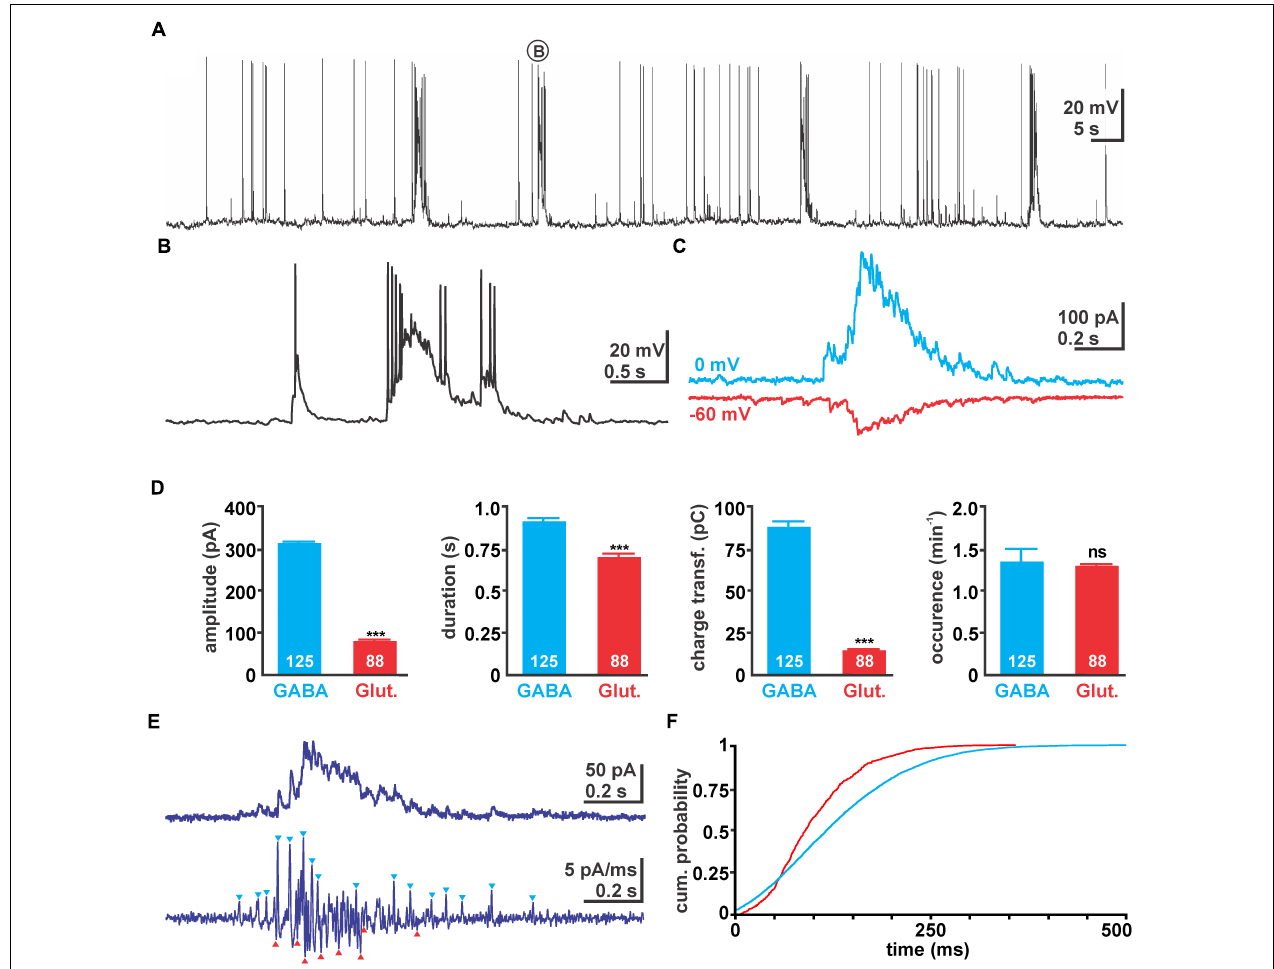
FIGURE 1 | Properties of giant depolarizing potential (GDP) activity in immature hippocampal slices. (A) Typical voltage traces recorded with 50 mM [Cl − ] p . Note the occurrence of massive depolarizing shifts triggering several action potentials (APs). (B) One typical GDP as indicated in (A) in higher temporal resolution. (C) Typical GDP associated currents recorded with 10 mM [Cl − ] p at 0 mV (blue traces) and –60 mV (red traces), reflecting GABAergic and glutamatergic currents, respectively. Note that the traces were recorded from the same neuron in two independent experiments and have been manually aligned. (D) Statistical evaluation of absolute current amplitude, duration, charge transfer, and occurrence of GDP associated GABAergic and glutamatergic currents. Glutamatergic currents have smaller amplitude and mediate less charge transfer. Values in the bar diagrams represent mean ± SEM, number of experiments are given in the bars, ∗∗∗ indicates a p -level of < 0.001. (E) Typical current recording using 10 mM [Cl − ] p at –30 mV. Since from this trace GABAergic outward currents and glutamatergic inward currents could not be separated easily (upper trace), the first derivative of this recording was calculated (lower trace). From this trace several outward and inward currents could be identified (blue/red arrowheads). (F) Cumulative probability plot of the identified GABAergic (blue, 4004 events) and glutamatergic (red, 699 events) post-synaptic events (PSCs) during a GDP calculated from 105 GDPs in 15 recordings. Note the earlier onset of GABAergic PSCs and that glutamatergic PSCs terminated much